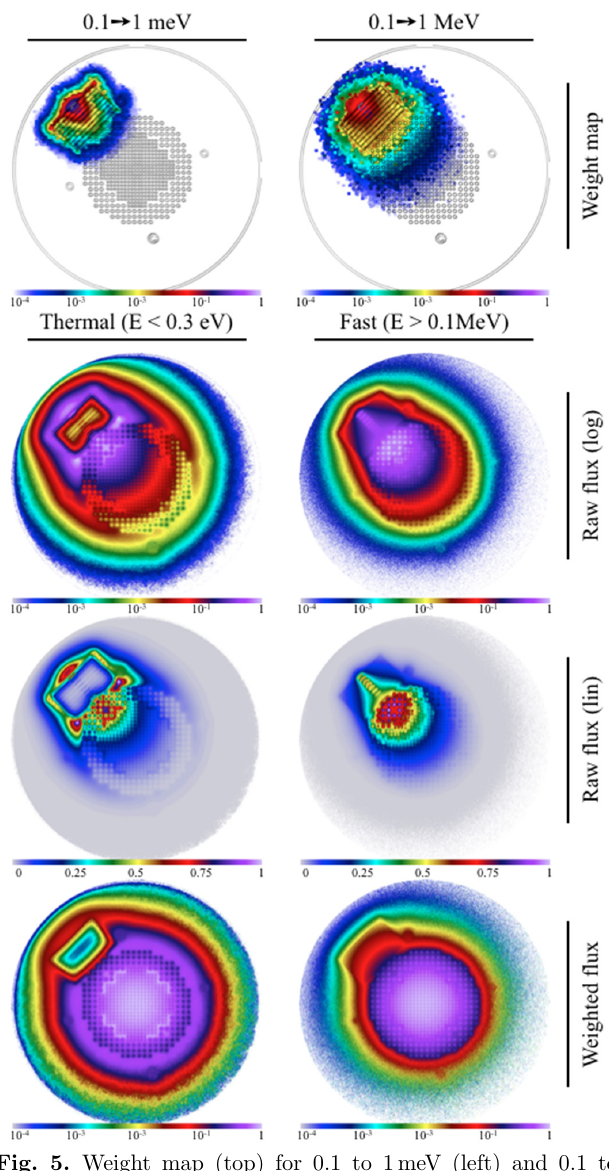
Fig. 5. Weight map (top) for 0.1 to 1meV (left) and 0.1 to 1MeV (right) neutrons, together with the raw thermal ( E < 0 . 3 eV) and fast ( E > 0 . 1 eV) flux represented with a logarithmic scale (second line) and linear scale (third line), and finally the weighted flux in the core (last